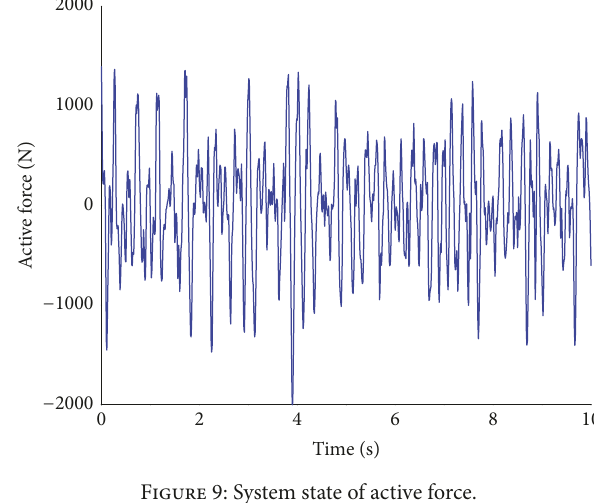
Figure 7: Deflection of the tire (left).